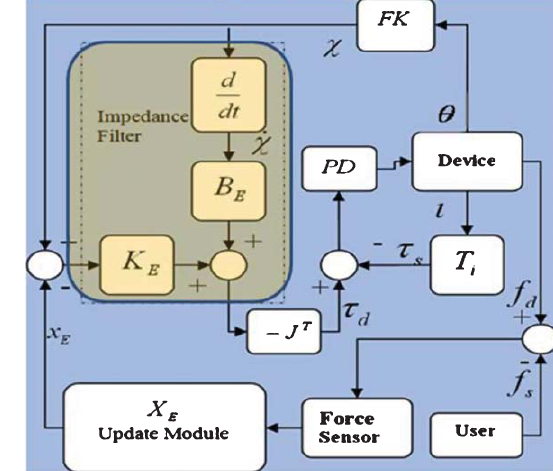
Fig. 5. Schema of the assistive control scheme.